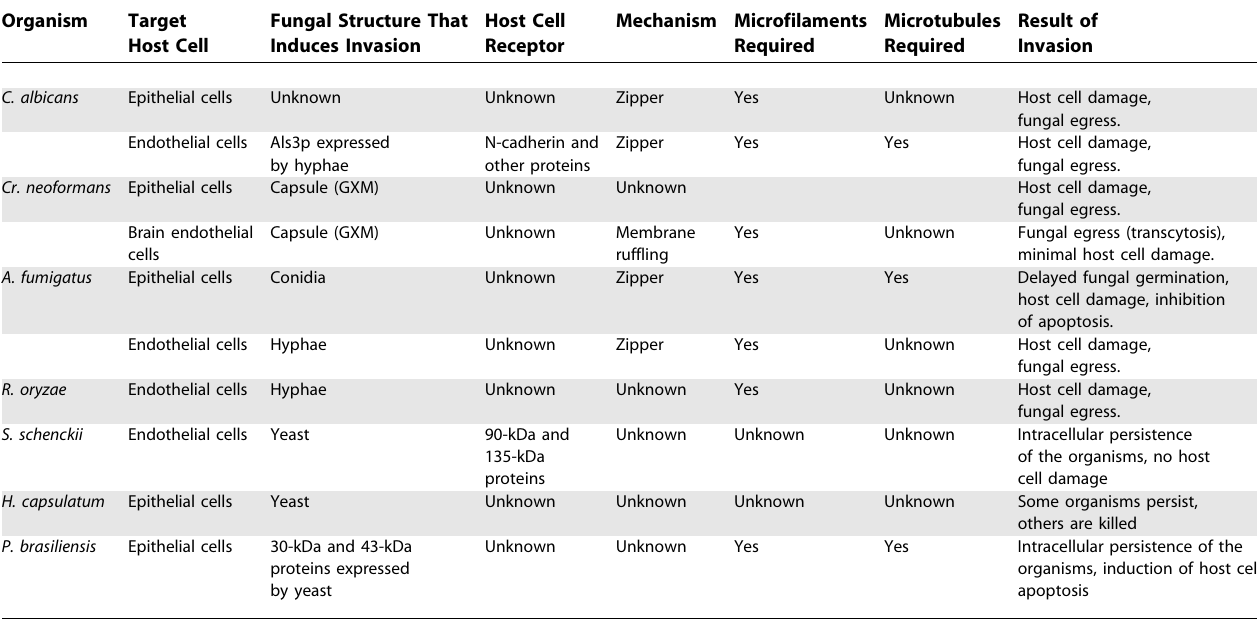
Table 1. Summary of the Invasion Mechanisms of the Different Fungi and Their Host Cell Targets